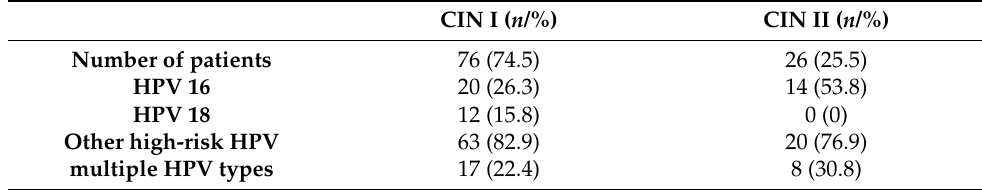
CIN cervical intraepithelial neoplasia, HPV human papilloma